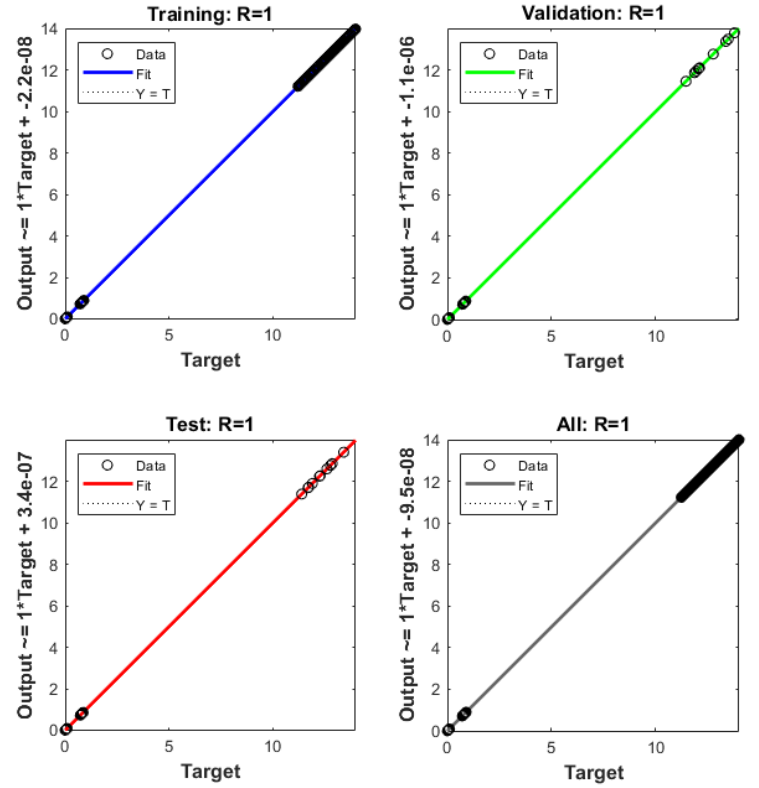
Figure 8. Case 3 Regression plots based on the nonlinear COVID-19 spreading model.